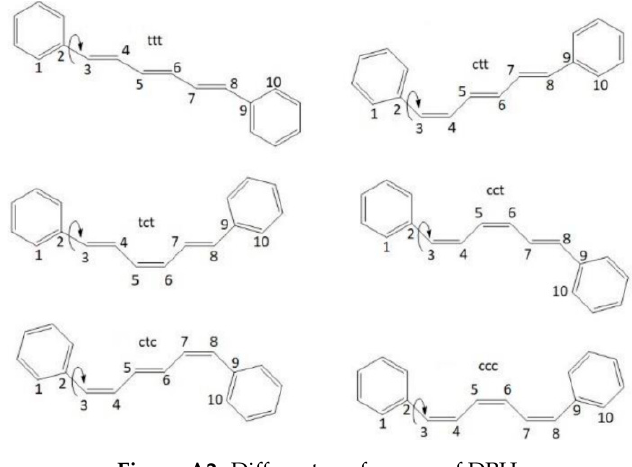
Molecules 2020 , 25 , x 12 of 19 respective double bond. Apart from the ttt conformer, the tct and ctt conformers are the least energetic Figure A1. Ground state rotational barriers for ( a ) dh1 (1-2-3-4), ( b ) dh3 (3-4-5-6), ( c ) dh2 (2-3-4-5) and ones with energy differences of 2.02 and 3.70 kcal/mol, respectively. The energy difference of more Figure A1. Ground state rotational barriers for ( a ) dh1 (1-2-3-4), ( b ) dh3 (3-4-5-6), ( c ) dh2 (2-3-4-5) and ( d ) dh4 (4-5-6-7) of DPH at the B3LYP / cc-pVDZ and SOSMP2 / cc-pVDZ level. than 10 kcal/mol with the ccc conformer is the largest. ( d ) dh4 (4-5-6-7) of DPH at the B3LYP/cc-pVDZ and SOSMP2/cc-pVDZ level.